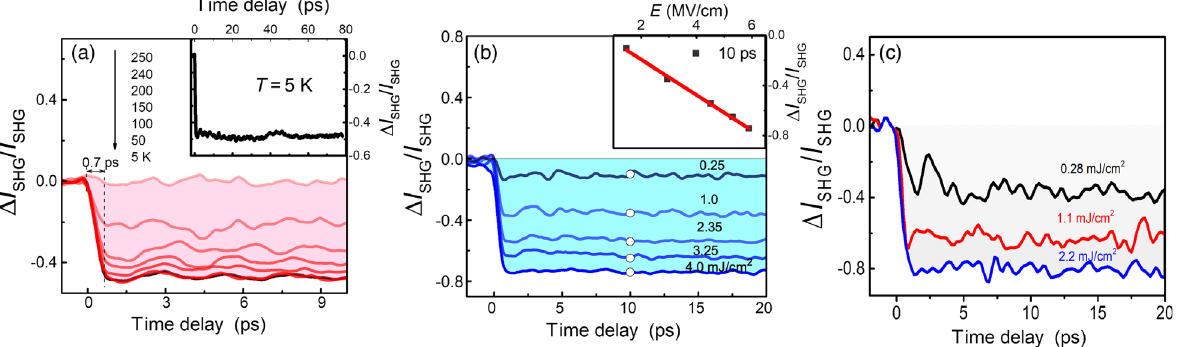
FIG. 4. (a) The relative change of SHG at fixed pump fluence of 800 nm about 2 mJ = cm 2 measured at different temperatures. The inset is the signal at longer time delay. (b) and (c) are pump-induced SHG time traces of MoTe 2 at selected fluences at T ¼ 10 K. The inset of (b) is the relative change of SHG at various pump field strengths. The pump pulse has a wavelength of 800 nm with 100-fs pulse width in (b) and a wavelength of 2 . 6 μ m with 35-fs pulse width in (c). Both of their incident probe pulses have a wavelength of 800